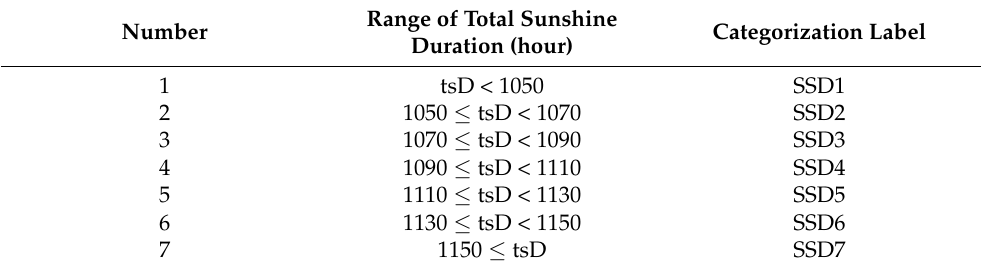
Table 7. Classification of total sunshine duration